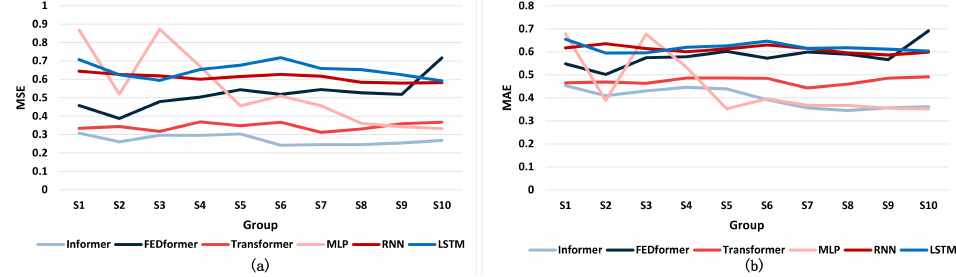
Figure 8. Changes in MSE of the model in different variable groupings: ( a ) MSE loss ( b ) MAE